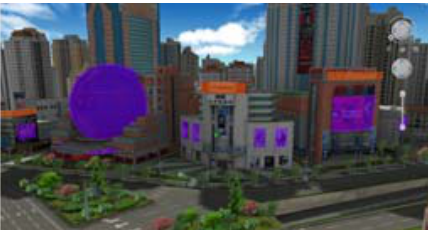
Figure 3. The overlay effect of outdoor advertising in the planning